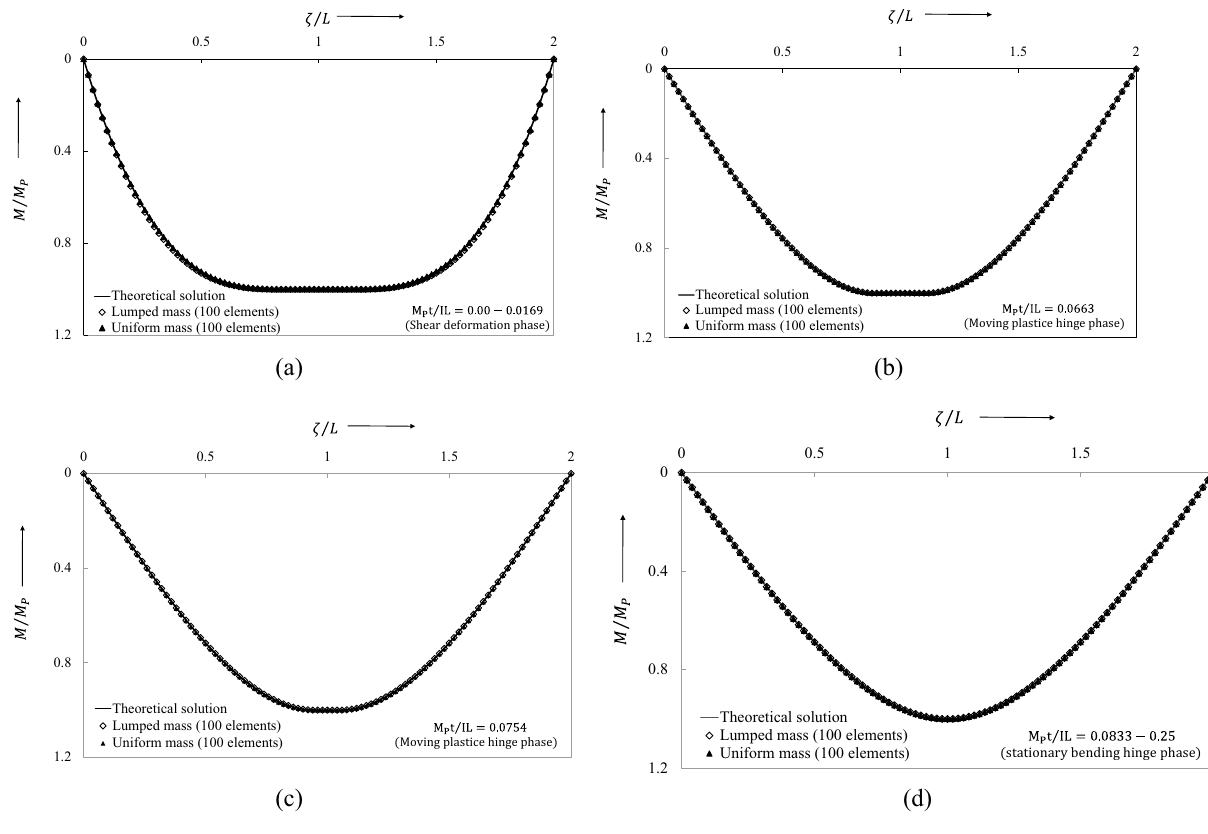
Figure 22. Dynamic bending moment evolution of flexural-shear critical impulsively loaded simply supported